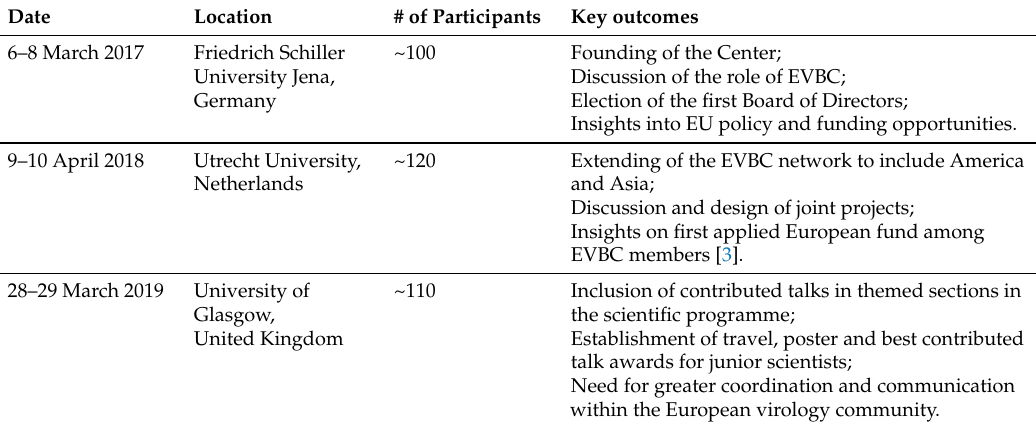
Table 1. History of the Annual Meeting of the European Virus Bioinformatics